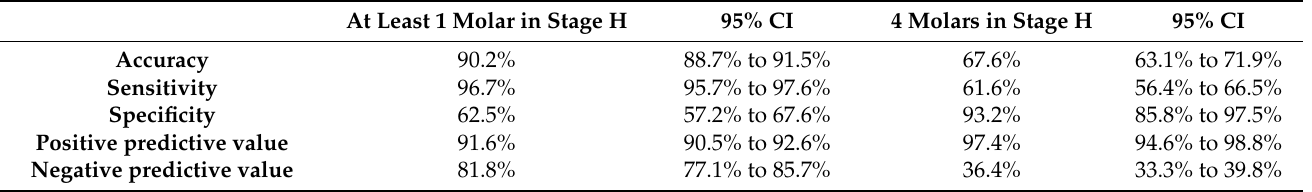
Table 2. Accuracy, sensitivity, specificity, positive predictive value and negative predictive value con- sidering two different conditions: development of at least one third molar (Stage H) or development of all four third